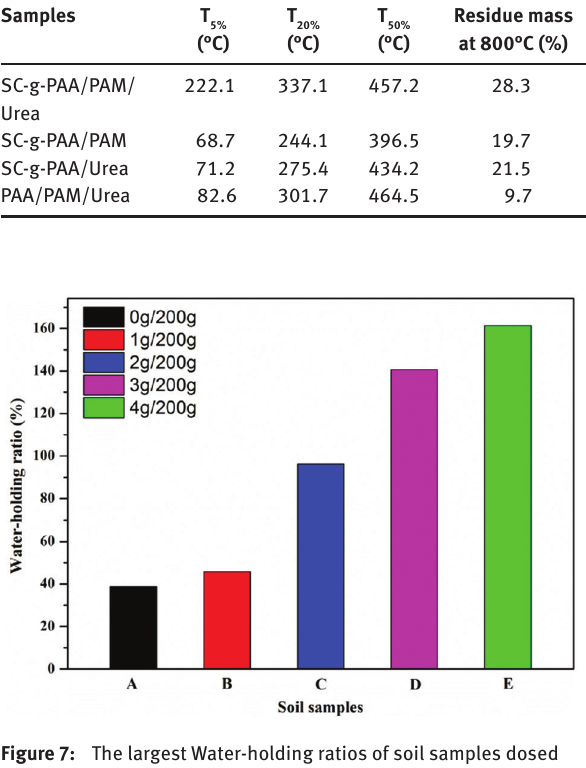
Figure 7: The largest Water-holding ratios of soil samples dosed with different amounts of